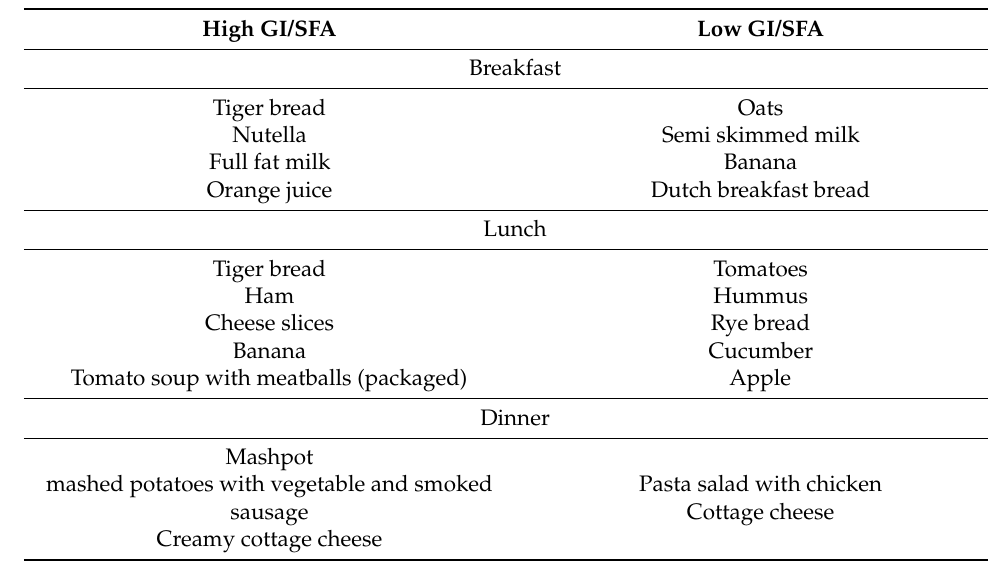
Table A1. Example